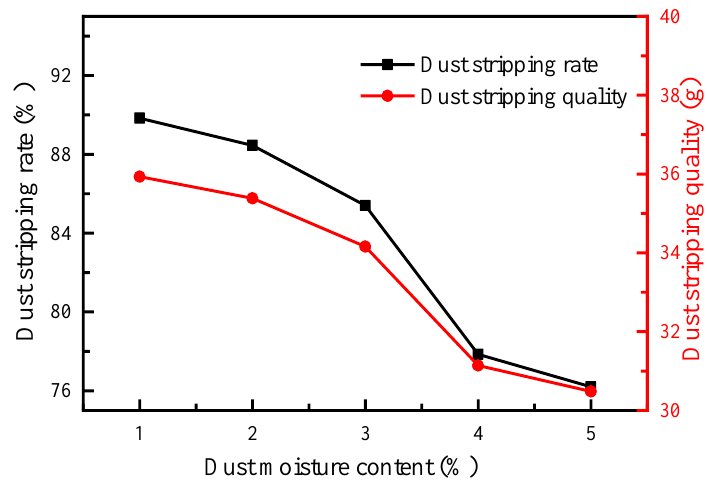
Figure 10. The effect of dust moisture content on dust stripping rate (DSR).